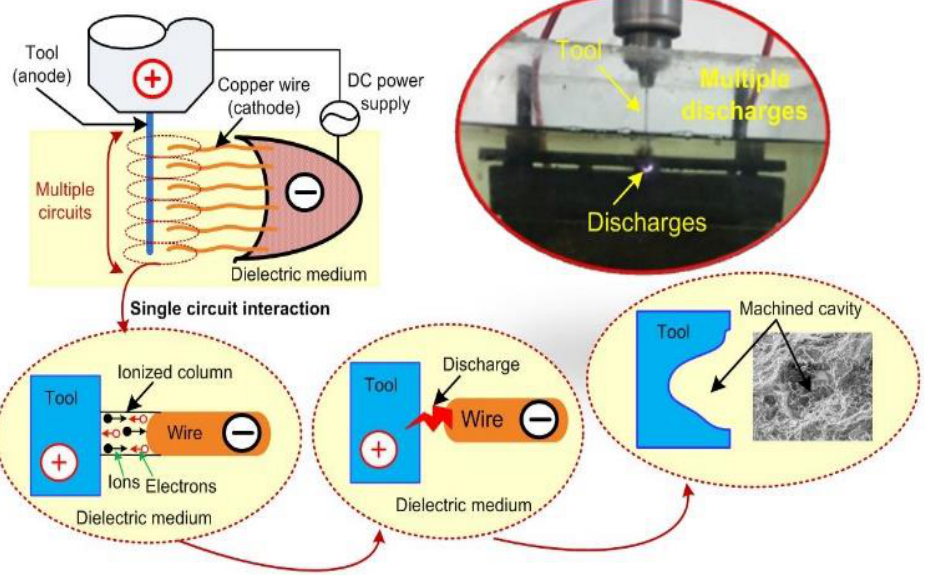
Figure 4. Mechanism for fabrication of rough tools by RM-MT-EDM process.